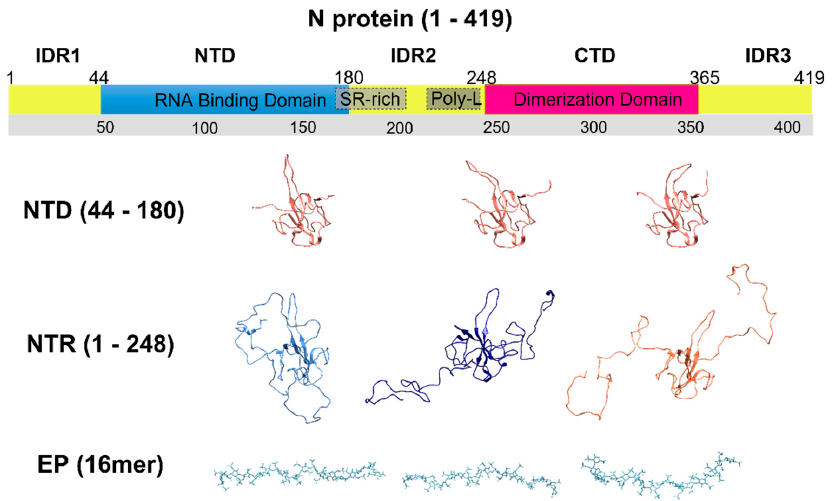
Figure 1. The scheme reported on top shows the modular organization of the nucleocapsid protein [12–15]. The IDRs are colored in orange (IDR1, IDR2, and IDR3), the NTD is in blue, and the CTD is in red. Some regions of IDR2 important for the discussion are also highlighted (SR-rich; Poly-L). The molecules studied in the present work (NTD, NTR, and EP) are illustrated below the scheme. Three NTD conformers from the 6YI3 [22] PDB entry were selected to show the structural heterogeneity adopted by some parts of NTD. Several NTR conformers were generated using the EOM software (version 3.0. EMBL, Hamburg, Germany) [32,33] based on the NTD conformers. Three of them are reported here to sketch the conformational space that can be sampled by the protein. The EP conformers were selected from the PDB entry 3IRI [34].